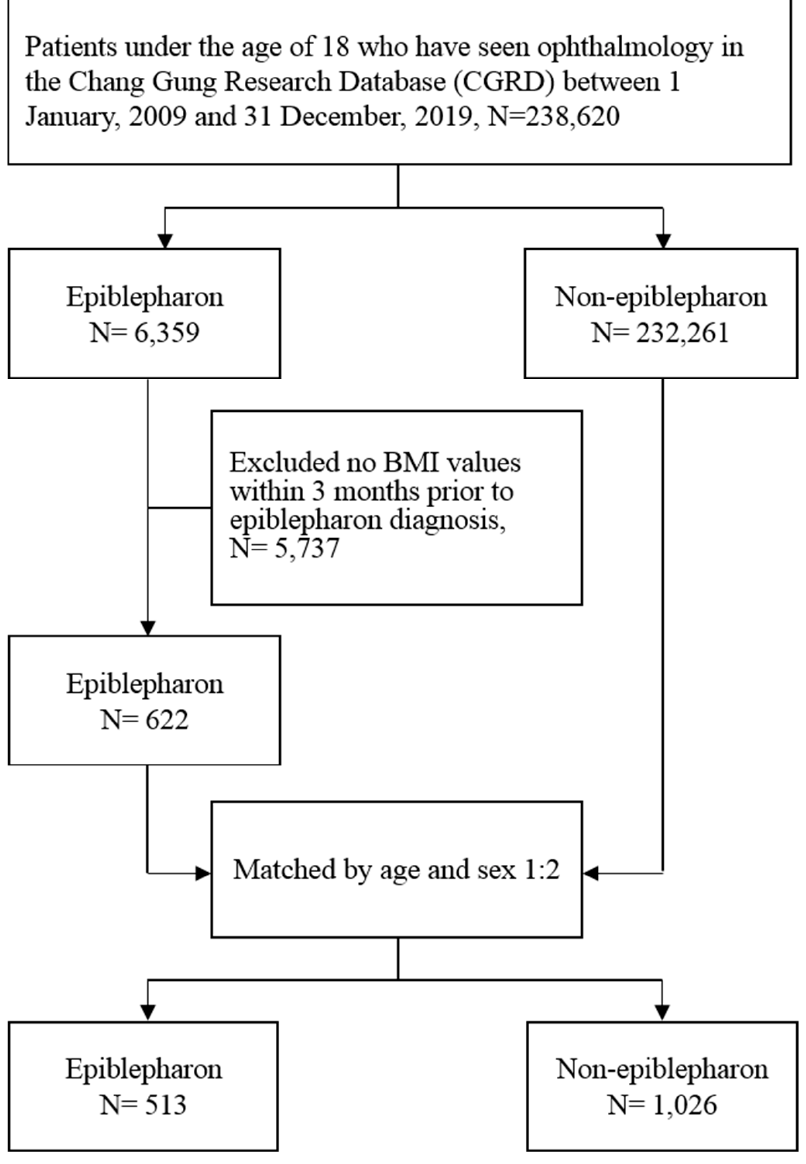
Figure 1. Flowchart of the study population selection.